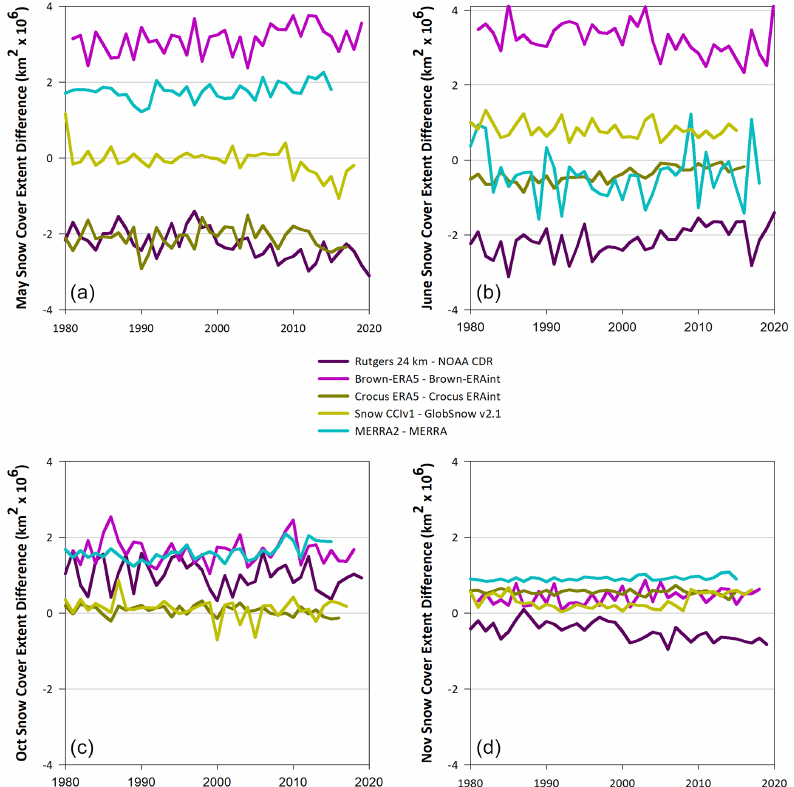
Figure 7. Product version differences in snow extent (new version minus previous version) for (a) May, (b) June, (c) October, and (d) Novem- ber.